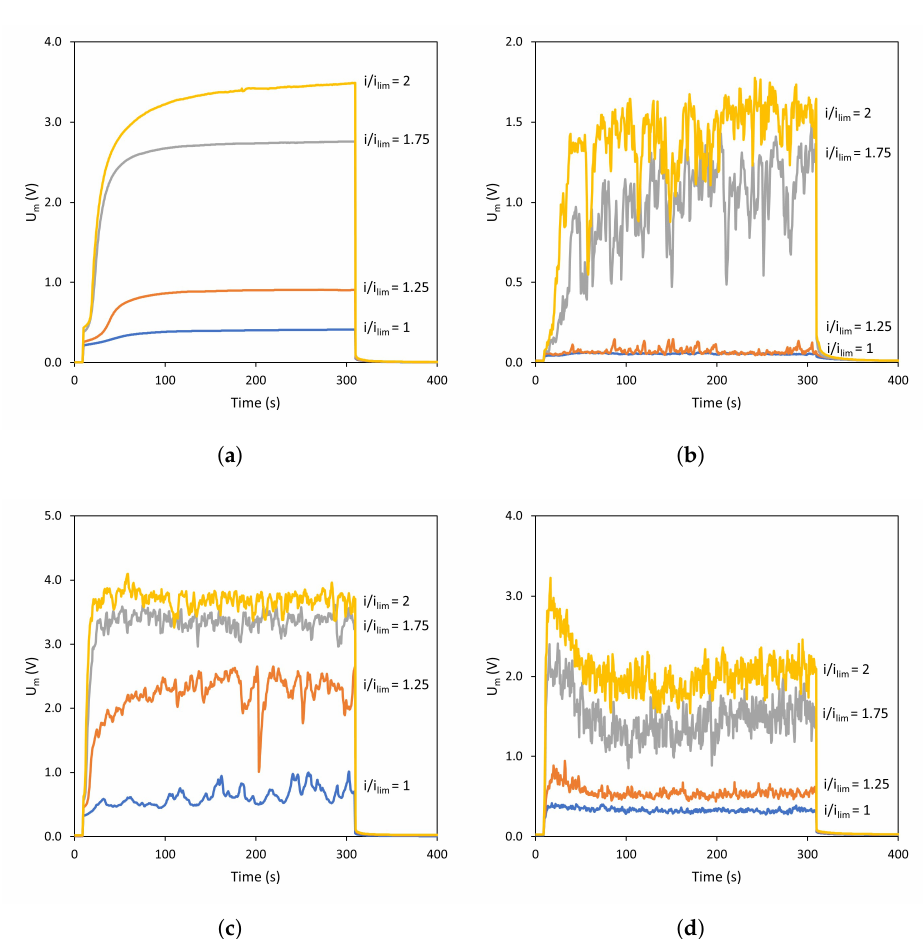
Figure A3. Chronopotentiometric response obtained with HC-A membrane and NaCl as